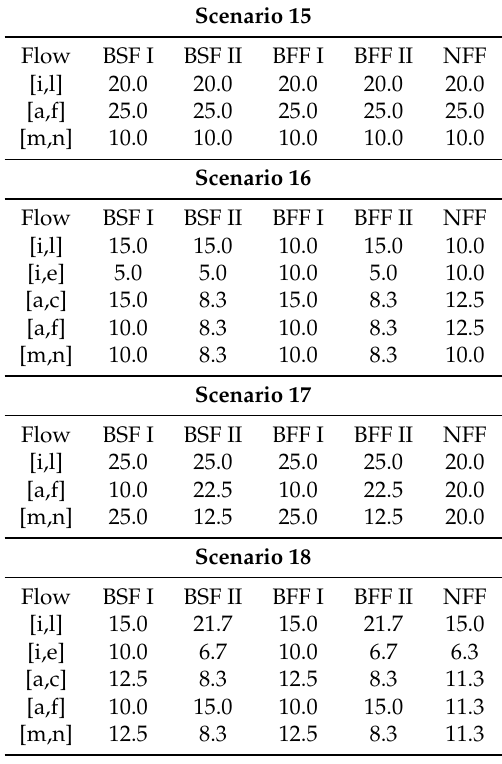
Table 5. Flow set and LP results for the flows’ end-to-end throughput for scenarios 15 to 18 described in Figure 16. All values in Mbps.